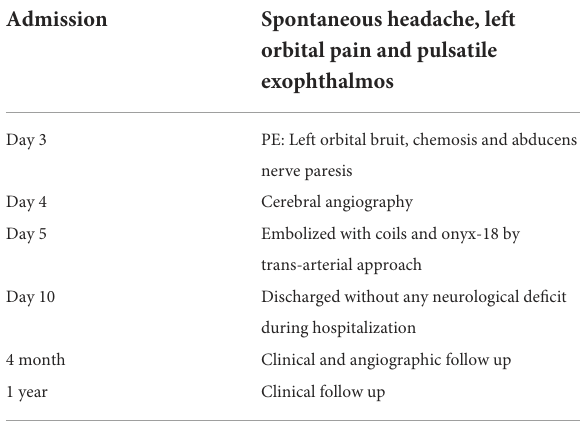
TABLE 1 Timeline of clinical and procedural data.